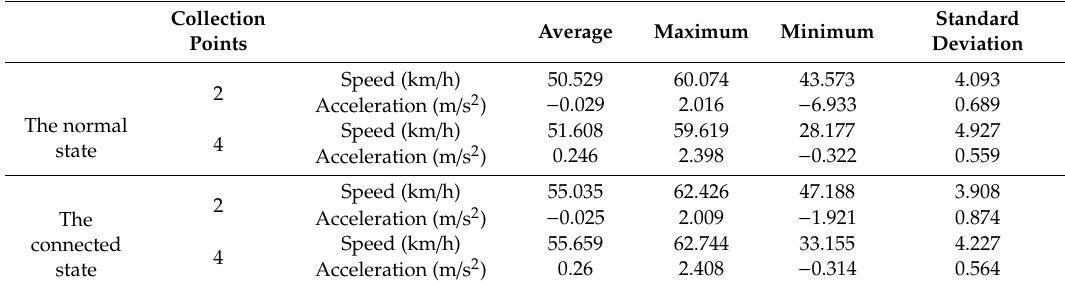
Table 4. Speed and acceleration of vehicles at collection points 2 and